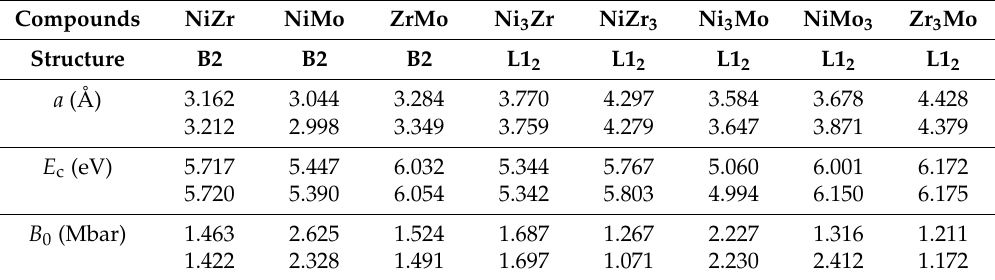
Table 4. Lattice constants ( a , Å), cohesive energies ( E c , eV), and bulk moduli ( B 0 , Mbar) of B2 and L1 2 compounds in the Ni-Zr-Mo system obtained from the potential (first line) and experiments or first-principle calculations (second line)